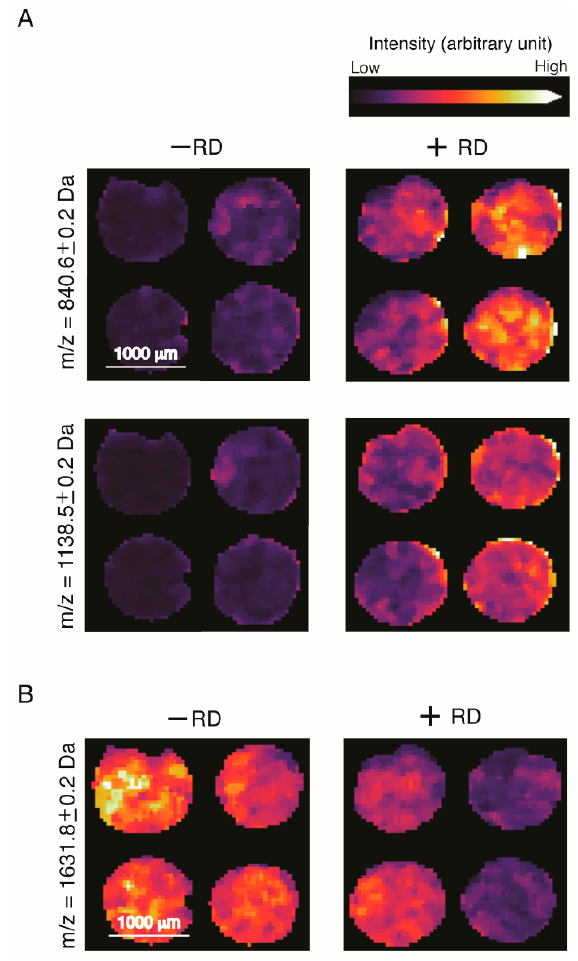
Figure 3. Characteristic peptides for group of patients with recurrence and no recurrence discrimination via individual peak mass spectra intensity and spatial peak distribution. ( A ) The m/z values 840.6 ± 0.2 and 1138.5 ± 0.2 Da show significantly higher spatial intensities (area under the curve (AUC) > 0.6; p < 0.001) in patients with recurrent disease (+RD) compared with without recurrence ( − RD). ( B ) In contrast, the 1631.8 ± 0.2 Da peptide, as an example, exhibited significantly higher intensities (AUC < 0.4; p < 0.001) in patients with no recurrence. Table 1. Receiver operating characteristic (ROC) curve analysis reveals a prognostic protein signature for early-stage HGSOC . Significantly differentially expressed proteins in primary tumors of patients